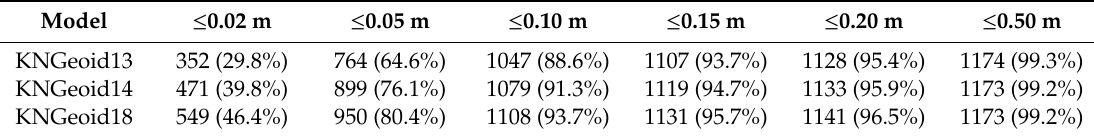
Table 6. Percentage of the 1182 UCPs whose absolute values of di ff erences between the geoid heights derived from the GNSS / leveling and those derived from the three KNGeoid models. Model ≤ 0.02